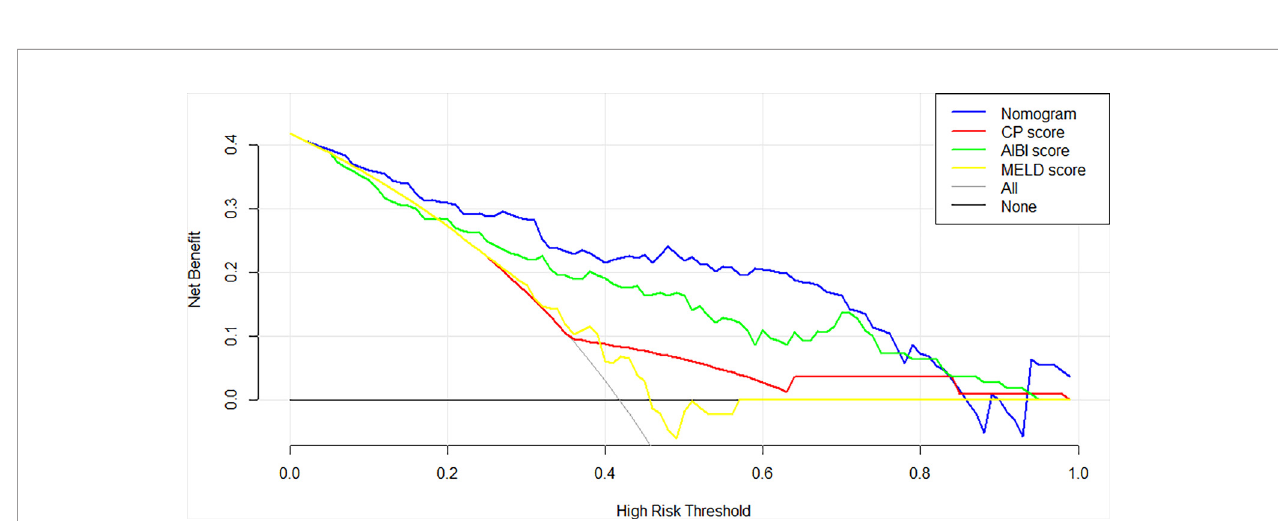
FIGURE 7 | Decision curve analysis of nomogram and the conventional models in the validation